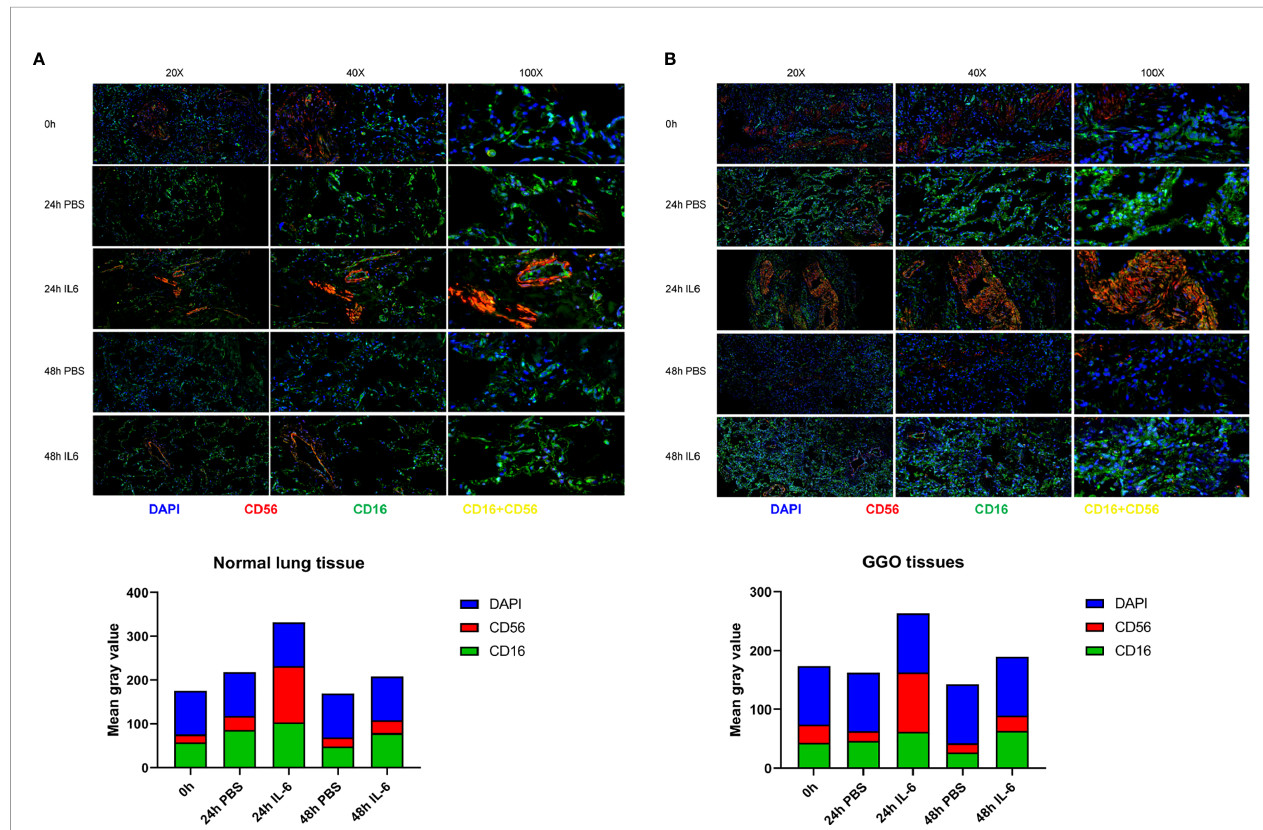
FIGURE 4 | The correlation between the expression of IL-6 and NK cells in lung adenocarcinoma with GGO. Images (upper) and the mean gray value (lower) show the immuno fl uorescence results in GGO tissues (A) and their paired normal tissues (B) after IL-6/PBS